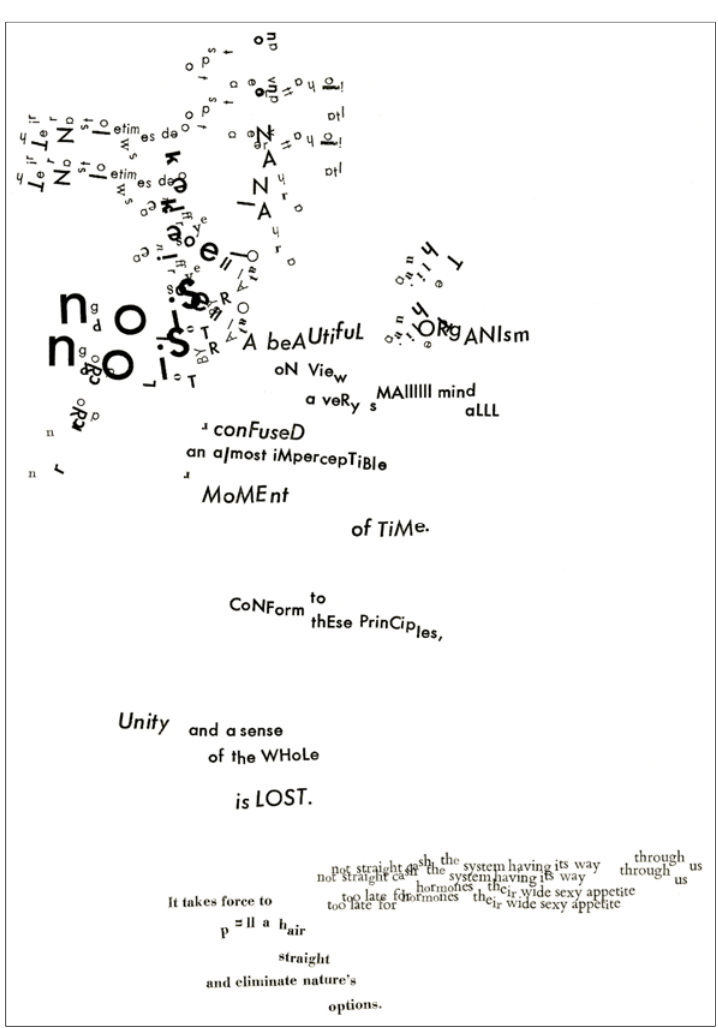
Figure 5. Stochastic